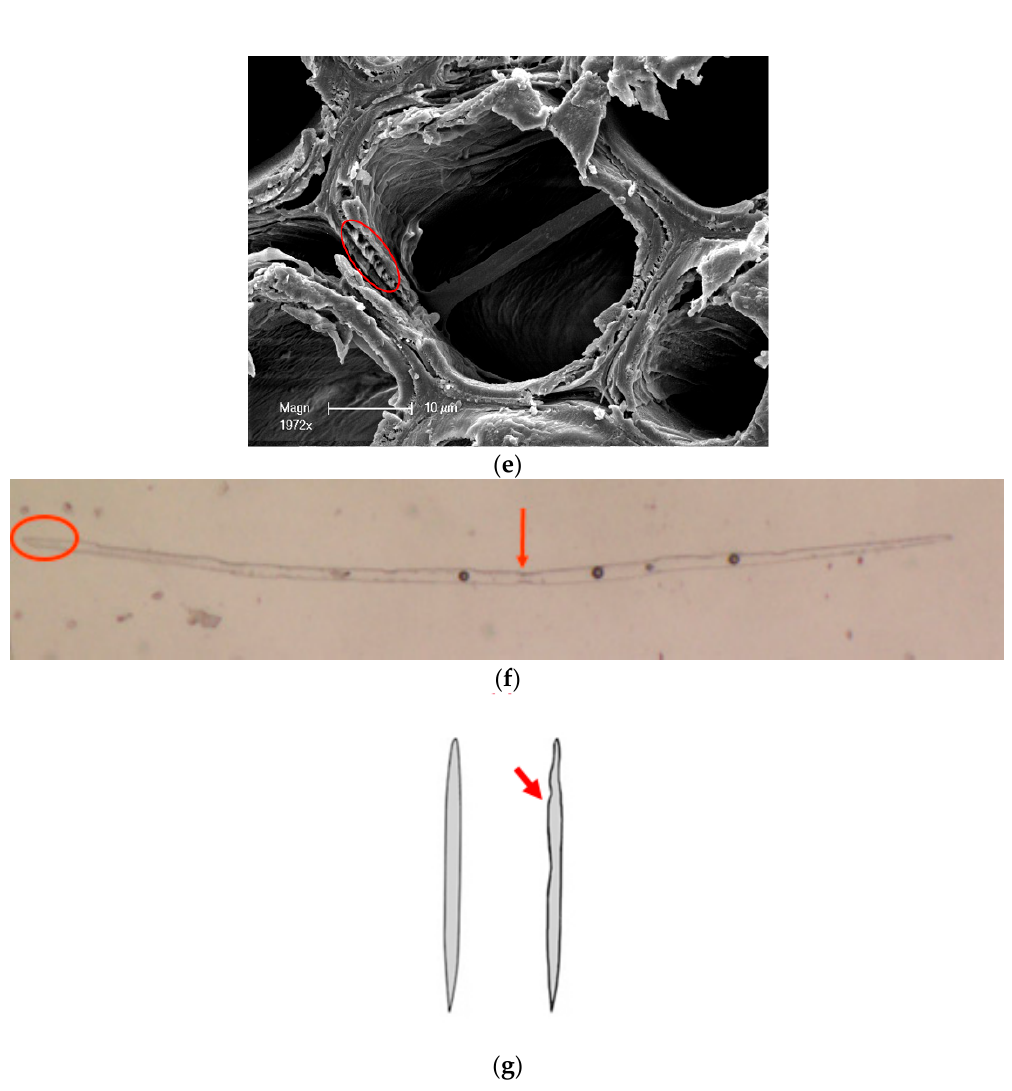
Figure 3. ( a ) Untreated wood samples; ( b ) Hyphae spread in the wood cells; ( c ) Hyphae spread by penetrating pit; ( d ) The cell wall became thinner after degradation, the arrow shows the area becoming thinner; ( e ) Treated wood samples; ( f ) The treated tracheid; ( g ) The change of tracheid before and after degradation. The surface of untreated tracheid (left) was smooth and the end of it was spinous. The end of the tracheid and the middle of treated tracheid (right) surface became rough.